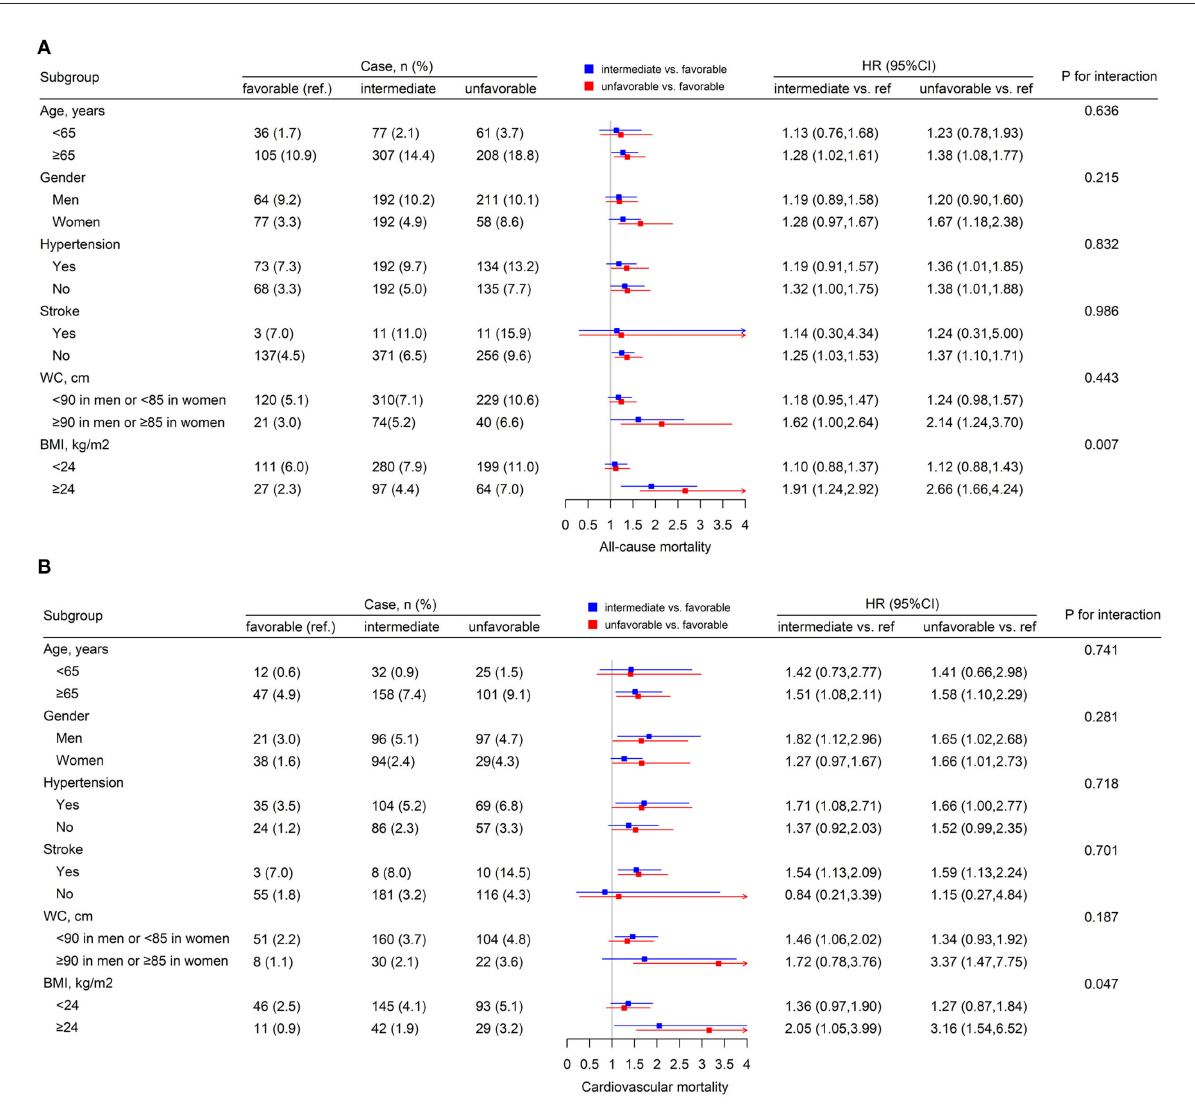
FIGURE3 The subgroup analysis for the lifestyle on all-cause (A) and CVD (B) mortality. Each subgroup analysis adjusted, if not stratified, for age, gender, BMI, waist circumference, hypertension, stroke, and anti-hypertensive